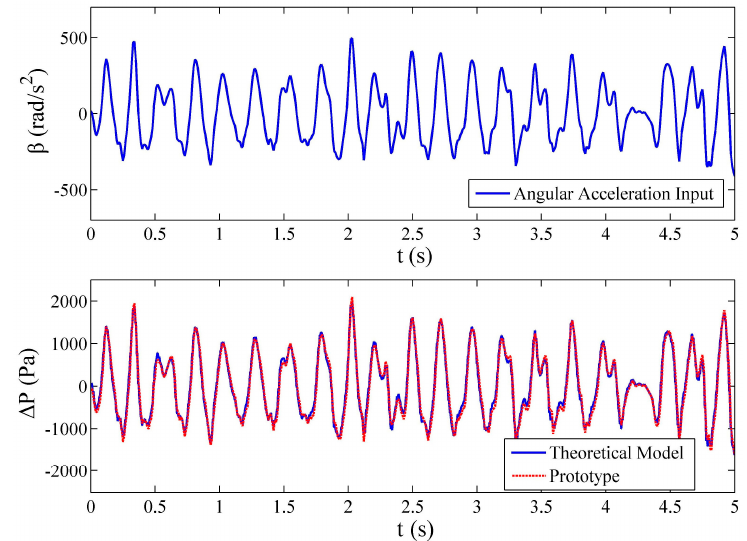
Figure 13. Comparison between the output of the prototype and the theoretical model responding to the same angular acceleration input. Prototype B, R h = 1.29 × 10 10 Ns/m 5 , V g / V = 5%, D = 2 r = 8 mm, e = 2 mm, k 0 = 1.98 × 10 − 12 m 2